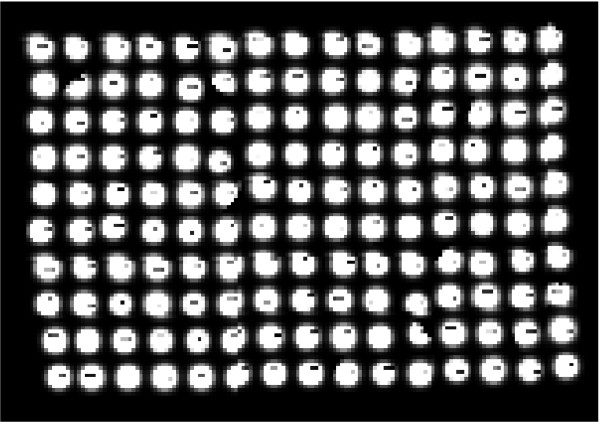
Drift in spot alignment. Systematic drift due to the unideal printing of the microarray slide can be introduced with used adjustable parameters.